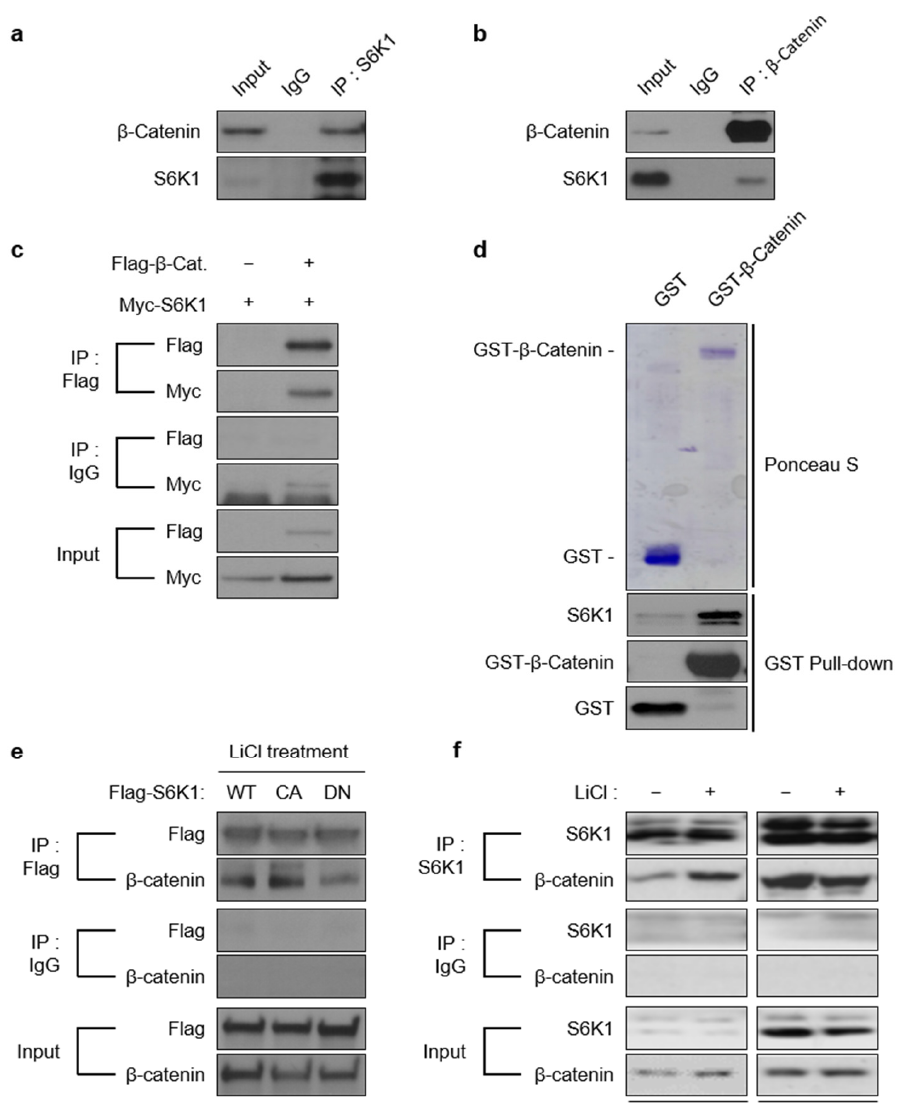
Figure 2. S6K1 binds directly to β -catenin. ( a , b ) Endogenous S6K1 binds to β -catenin. Co-immunoprecipitation assays were performed in DLD-1 cells using S6K1 ( a ) and β -catenin ( b ) antibodies. Each binding partner was detected by immunoblot performed with the indicated antibodies. ( c ) Exogenous S6K1 binds to β -catenin. Co-immunoprecipitation assay was performed using Flag-antibody and 293T cells that were transiently transfected with exogenous Flag- β -catenin and Myc-S6K1. Immunoblot was performed with anti-Flag and anti-Myc antibodies. ( d ) S6K1 binds to β -catenin in vitro. In vitro GST pulldown assay was performed using recombinant GST or recombinant GST- β -catenin with 293T cell extracts. Presence of the GST and GST-fusion proteins were confirmed by Ponceau staining ( top ). Eluted S6K1 and GSTs were detected by immunoblot performed with anti-S6K1 and anti-GST antibodies ( bottom ). ( e ) S6K1 binds to β -catenin in a kinase activity-dependent manner. Co-immunoprecipitation assay was performed using Flag-antibody and 293T cells stably expressing Flag-tagged WT, CA, and DN forms of S6K1 treated with LiCl (25 mM) for 8 h. ( f ) The interaction between nuclear S6K1 and β -catenin was increased in a Wnt activation-dependent manner. Co-immunoprecipitation assay was performed using S6K1 antibody and cytoplasmic and nuclear extracts from 293T cells treated or untreated with LiCl (25 mM, 8 h).